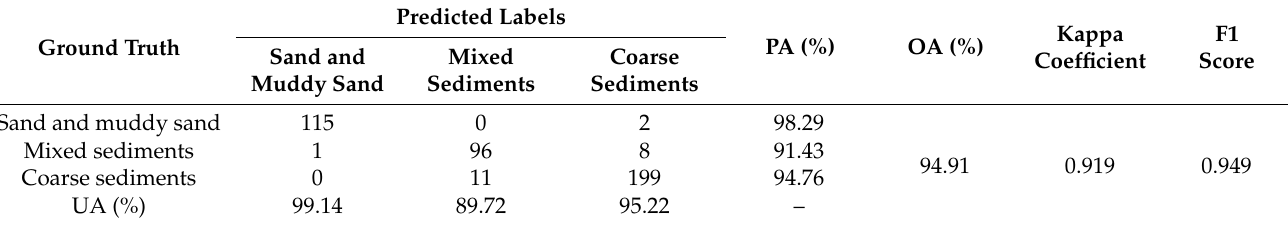
Table 4. Confusion matrix of RPNet in